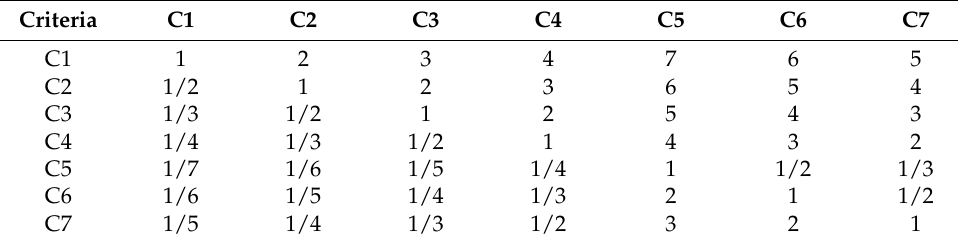
Table 8. Comparison matrix of the adopted decision criteria.